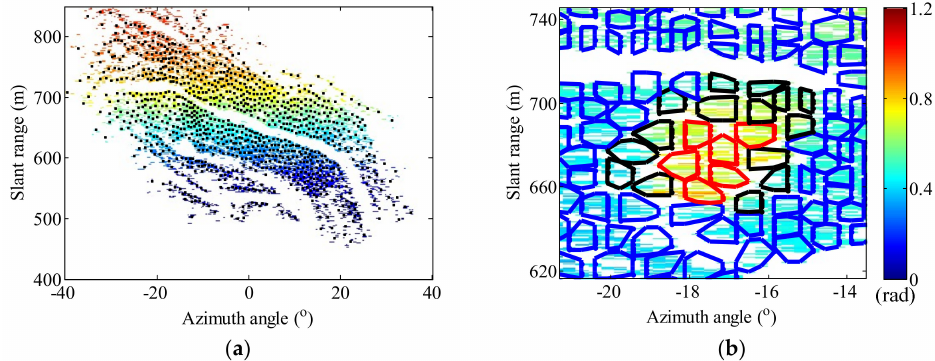
Figure 13. ( a ) Cluster partition map. ( b ) Three types of